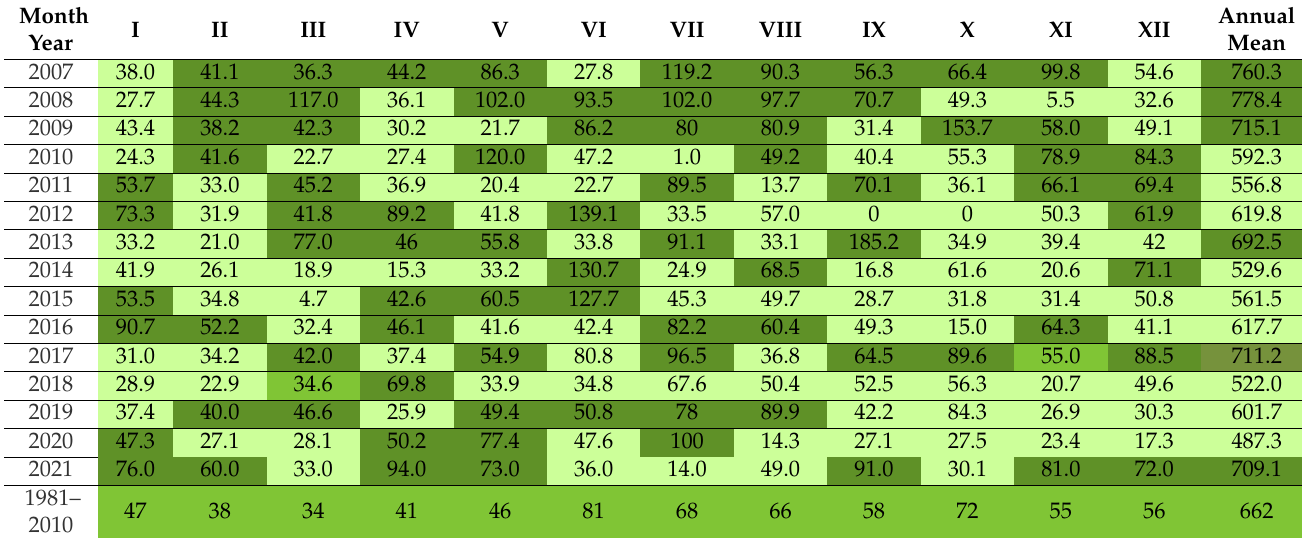
Table 4. Average monthly and annual mean precipitation for the observation period and their average values for the 30-year period (1981–2010). Dark and light green shows the deviation towards higher or lower precipitation